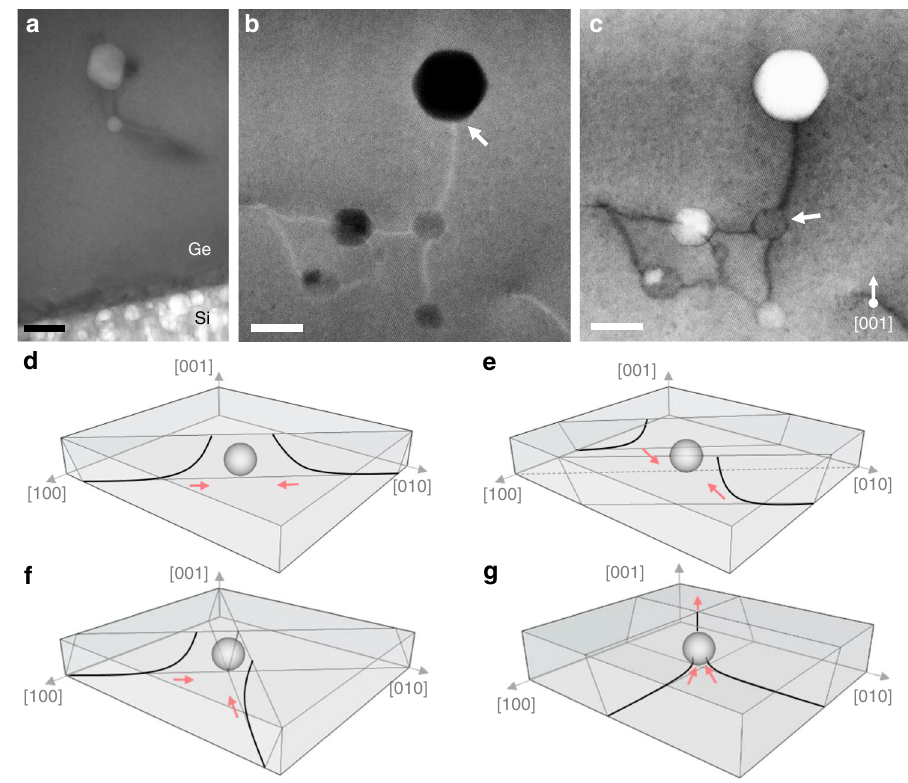
Fig. 3 Possible mechanisms responsible for dislocation annihilation. a Low magni fi cation transmission electron microscopy (TEM) image close to the Ge/Si interface showing the presence of the voids in the Ge layer as well as in the Si substrate. Scale bar 100 nm. Scanning transmission electron microscopy (STEM) images present different interactions between dislocations and voids in dark fi eld ( b ) and bright fi eld ( c ). Scale bars 50 nm. The gliding dislocations in the Ge layer shows slight curvature to join the void area until its complete annihilation. Possible processes for annihilation of threading dislocations at the void surface by interaction of several threading segments from: the same slip system ( d ), the parallel slip system ( e ), by a combination of glide and slip motion ( f ), and by fusion ( g ). Source data are provided in the Source Data fi